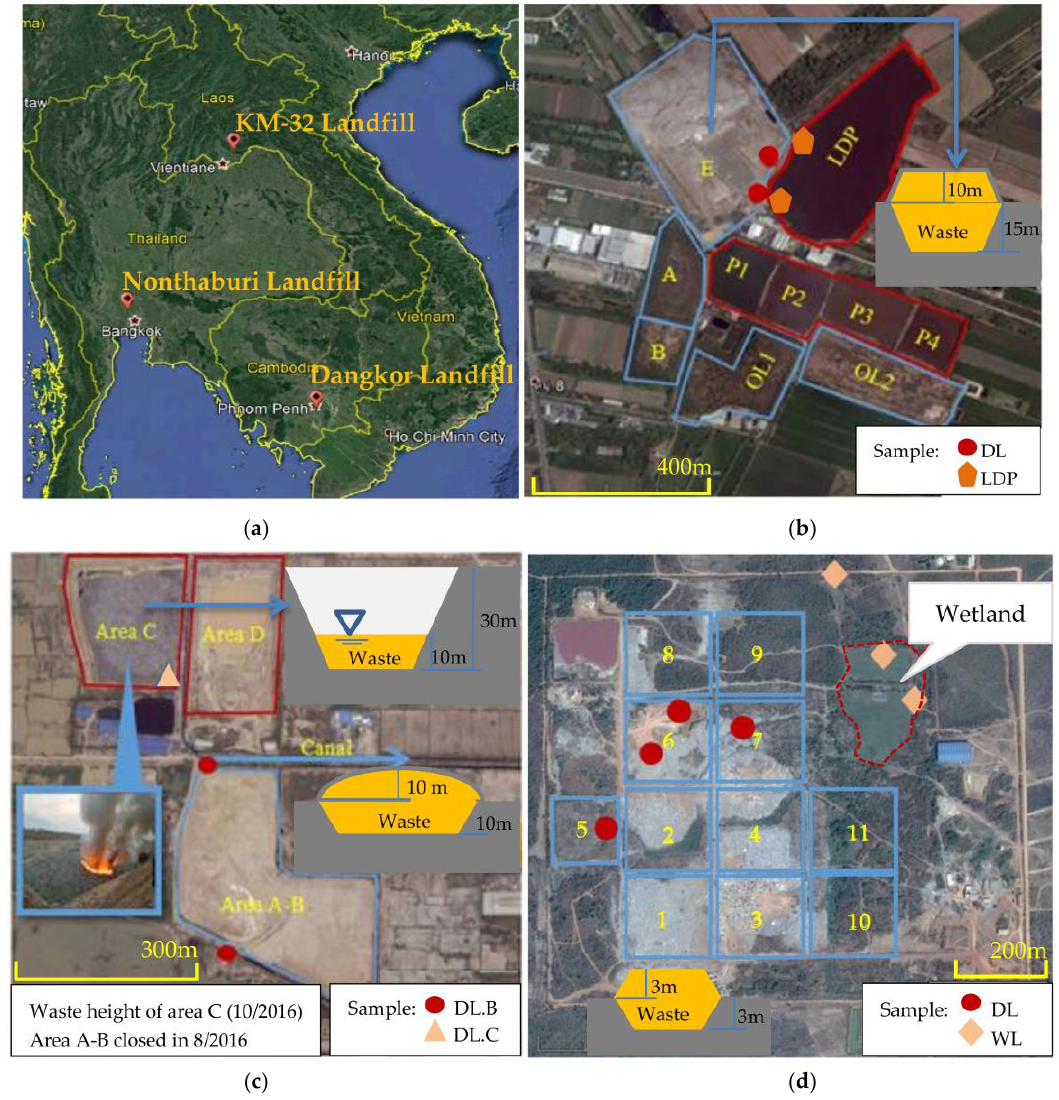
Figure 1. Locations of the study sites, and the landfill plan of the sampling points superimposed on the Google Earth image, the pit depth and waste height of the dumping facility. ( a ) Landfill location; ( b ) Nonthaburi landfill; ( c ) Dangkor landfill; ( d ) KM-32 landfill. DL: direct leachate; LDP: leachate discharge pond; DL.B: direct leachate from area B; DL.C: direct leachate from area C; WL: wetland. Table 1. Summary of landfill information (as of March 2017).